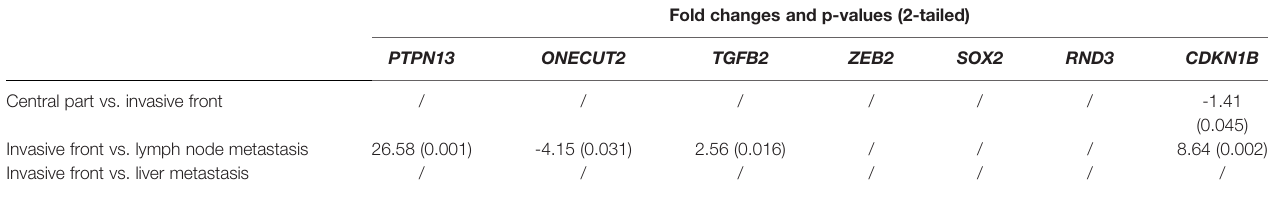
TABLE 4 | Expression of the miR-200 family related genes (Wilcoxon signed ranks test).